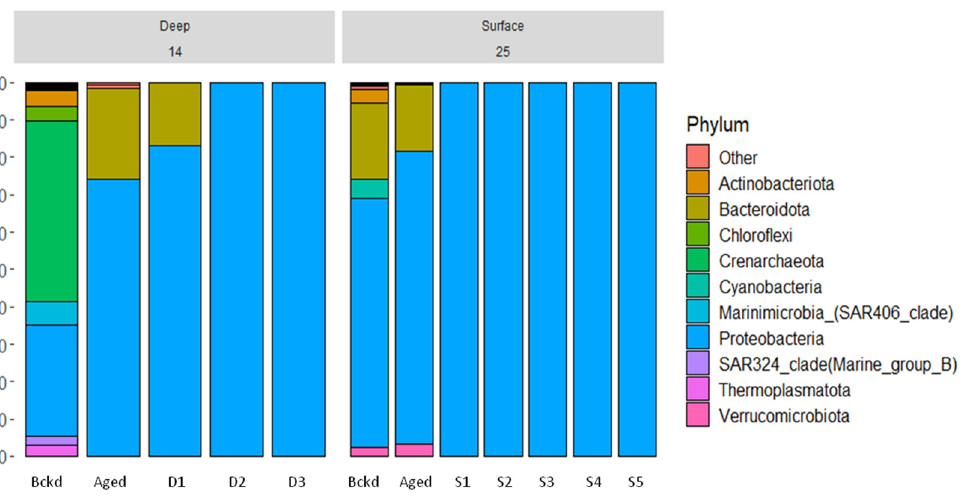
Figure A1. Relative abundance of bacterial taxa at the phylum level for Surface and Deep enrichments.